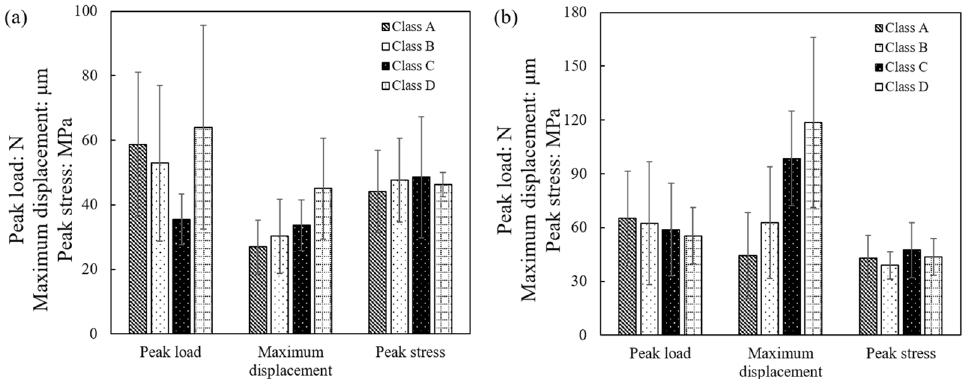
Figure 21. Peak load, maximum displacement (corresponding to peak load) and peak stress for the different classes of curves at velocities of: ( a ) 0.01 mm/min; ( b ) 1 mm/min. different classes of curves at velocities of: ( a ) 0.01 mm/min; ( b ) 1